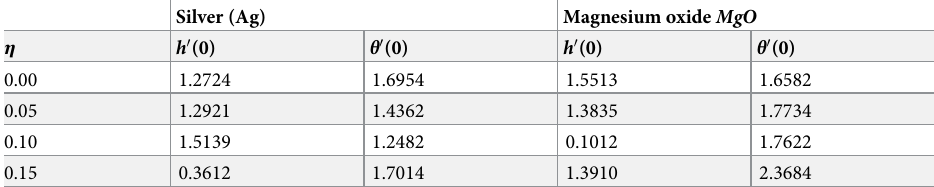
Table 4. Quantitively analysis for Nusselt number and Skin